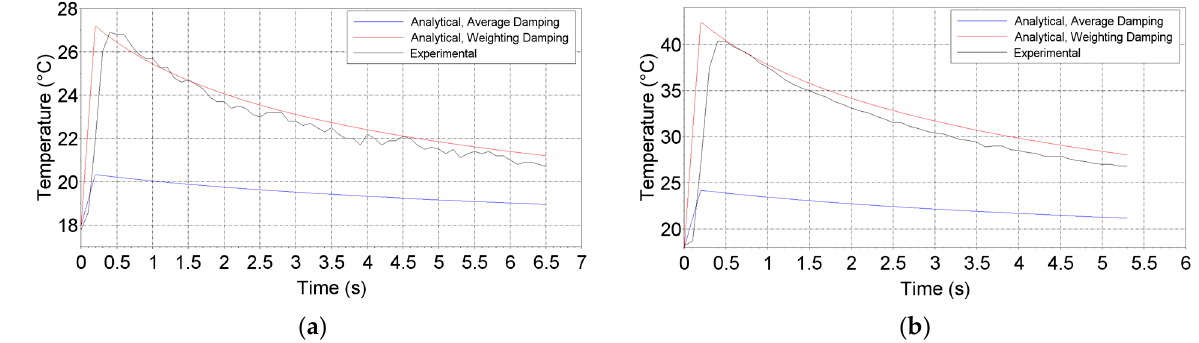
Figure 20. Experimental and computational model temperature comparison, 316L D3 stainless steel, UHCF specimen: ( a ) Maximum stress = 200 MPa, t on = 0.2 s, t off = 5 s, 1 pulse; ( b ) Maximum stress = 270 MPa, t on = 0.2 s, t off = 5 s, 1 pulse.